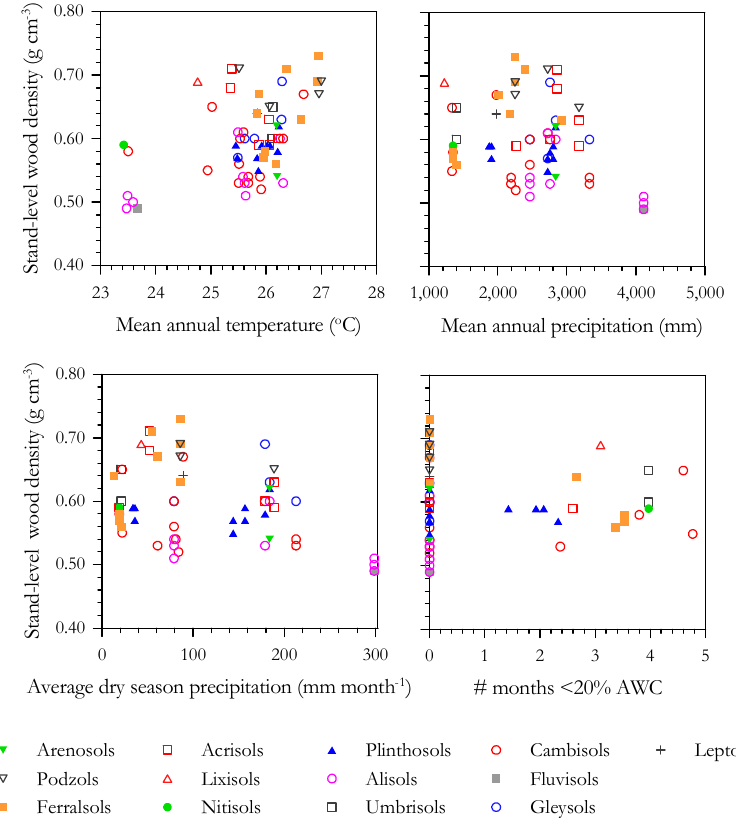
Fig. 8. Relationships between stand wood density and climatic